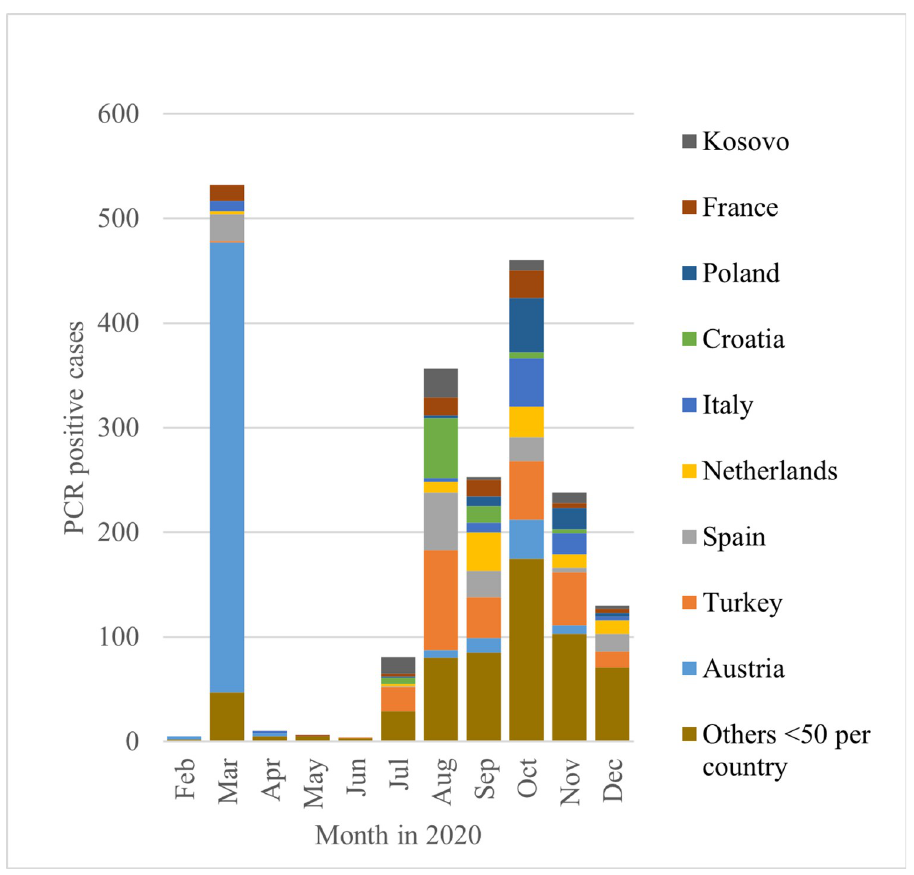
Fig 4. Infections after travel